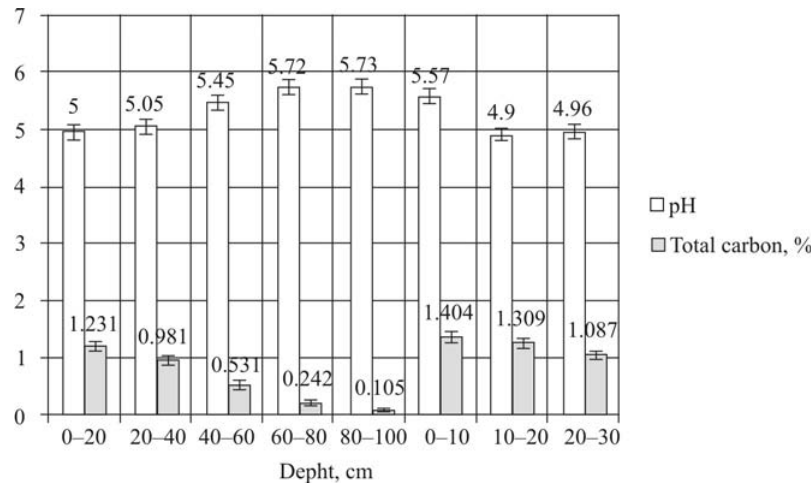
Fig. 2. Soil pH and total carbon content in the first meadow plot